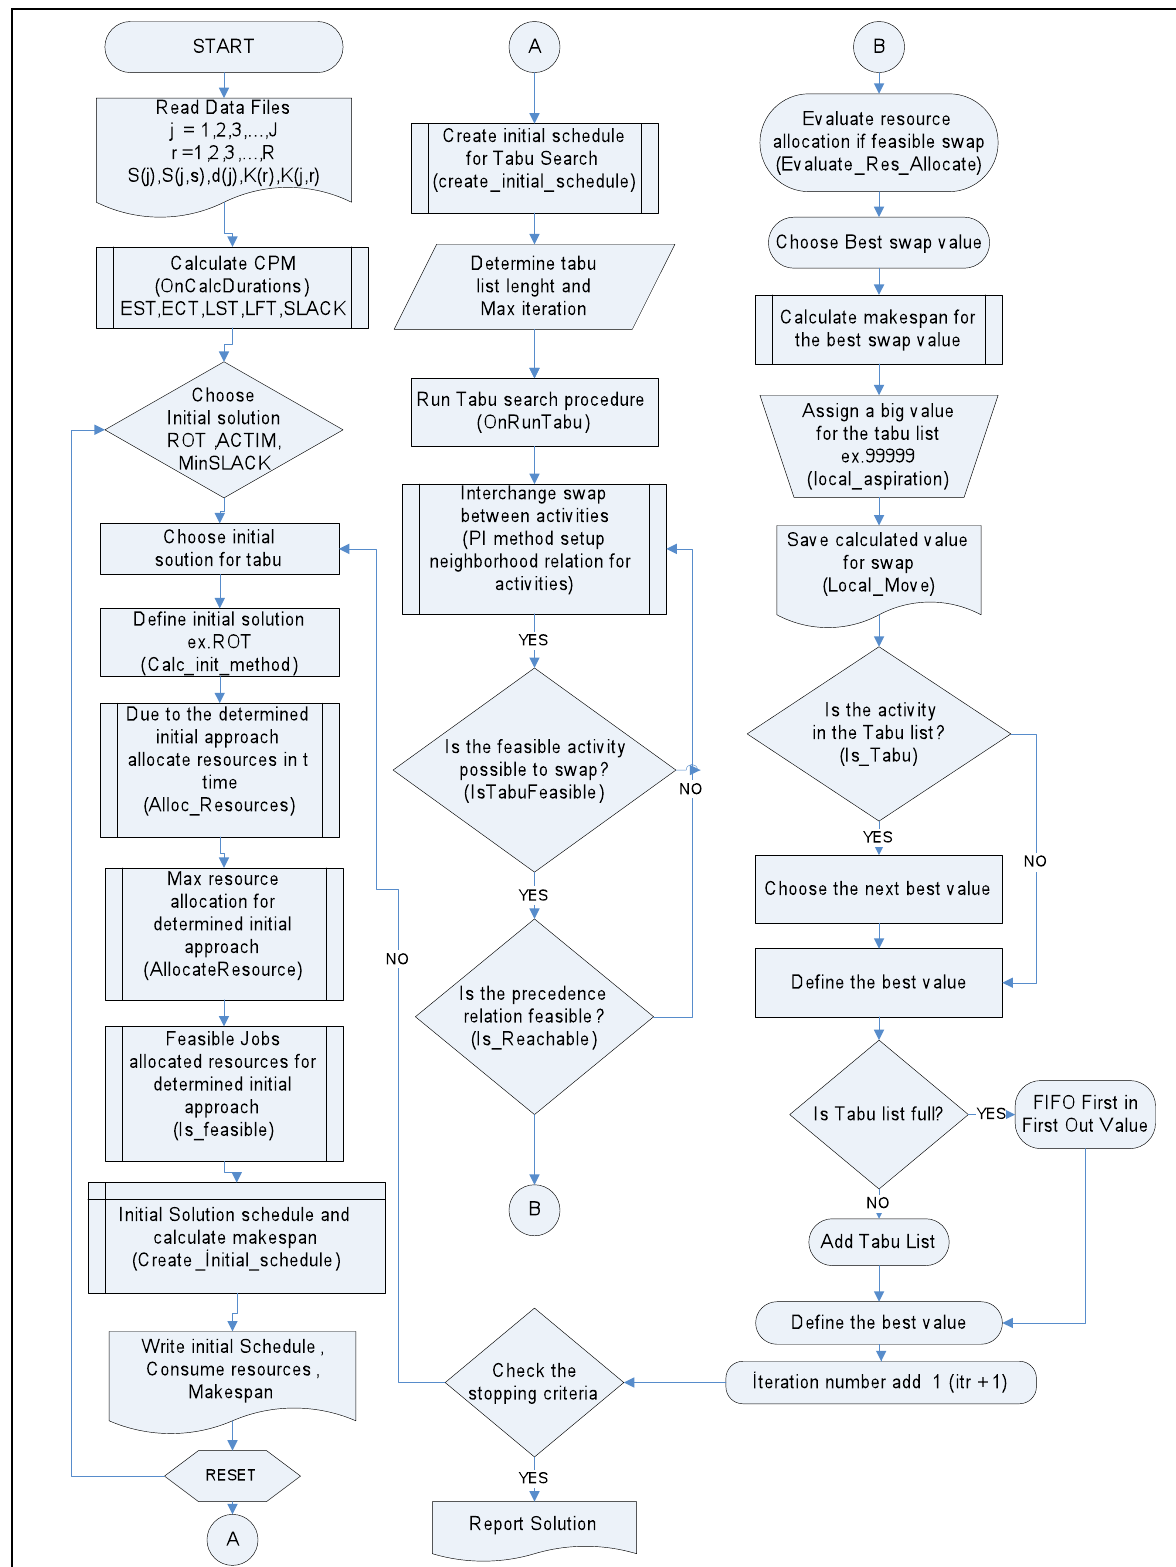
Figure 3. Flowchart summarizing the basic steps of the proposed approach